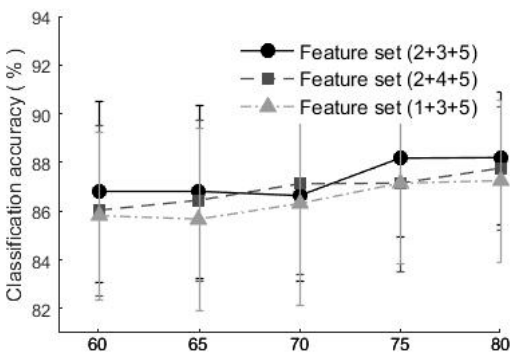
Figure 9. The classification accuracy based on different numbers of training samples.